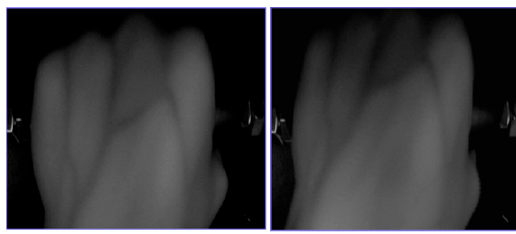
Figure 17. Difference in rotation angle.